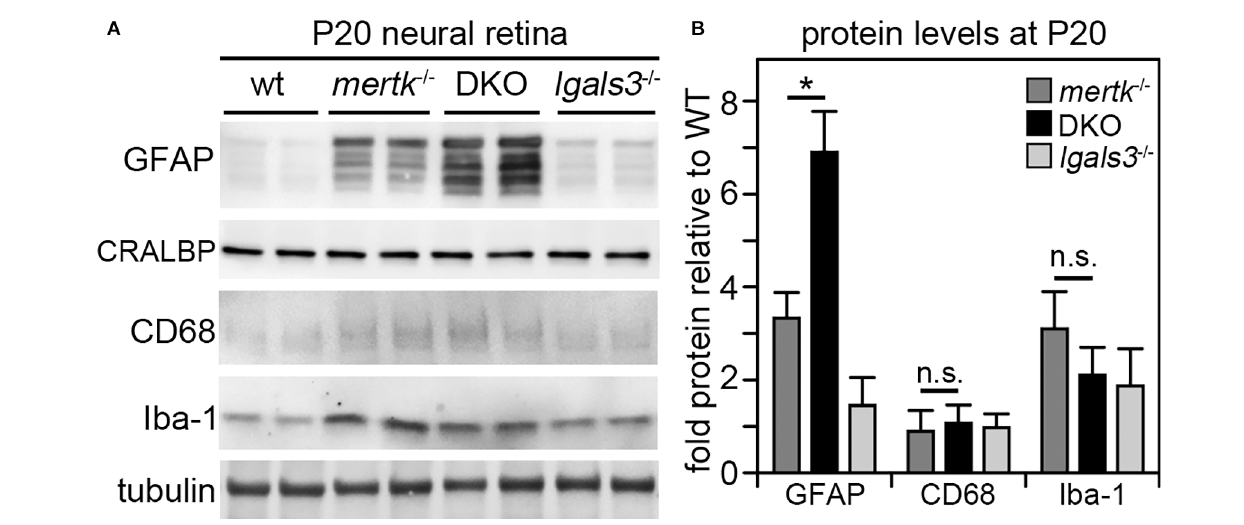
FIGURE 5 | Galectin-3 deficiency in mice lacking MERTK robustly increases GFAP protein levels by P20 implying Müller glia activation at an age prior to photoreceptor degeneration. Tissues from age-matched WT, mertk -/- , DKO, and lgals3 -/- mice were dissected to yield isolated neural retina samples, which were analyzed by comparative immunoblotting. Two representative samples from two different mice of each genotype are shown on the same blot in (A) . Blots were probed for Müller activation marker GFAP, constitutive Müller glia protein CRALBP, microglia activation marker CD68, and constitutive microglia protein Iba-1 as indicated. Tubulin reprobing was used to control for the total sample load. Quantification of results from blots as in (A) yielded bar graph shown in (B) . Bars show mean ± s. d.; n = four biological samples from four different mice. Data were analyzed by ANOVA; * indicates p < 0.05; n. s. indicates no significant difference ( p >